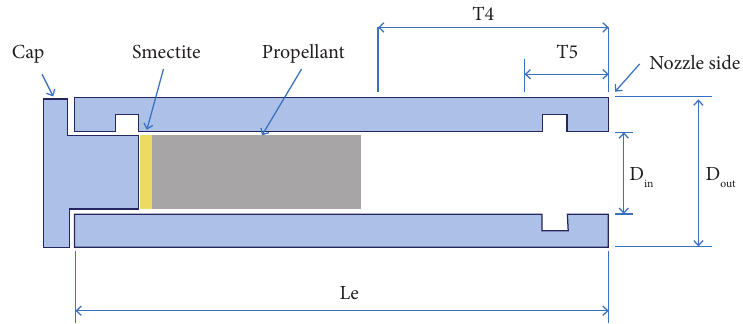
Figure 9. Essential parts of NRB and Urano engine and thermocouples